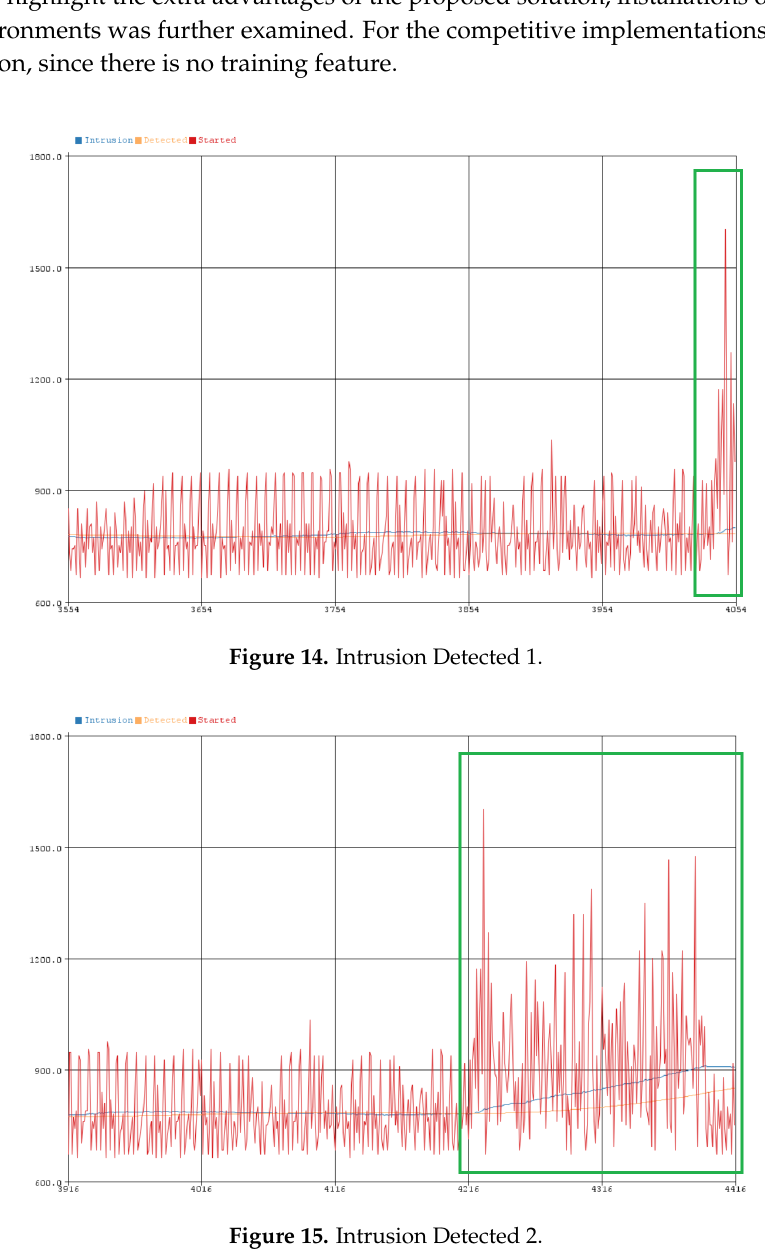
Figure 15. Intrusion Detected